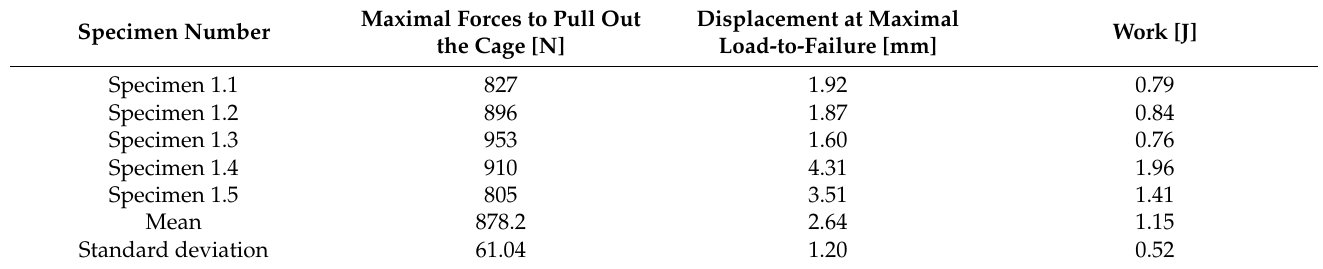
Table 3. Maximal forces and work to tear out the cage and implant displacement under stress in Group 2.